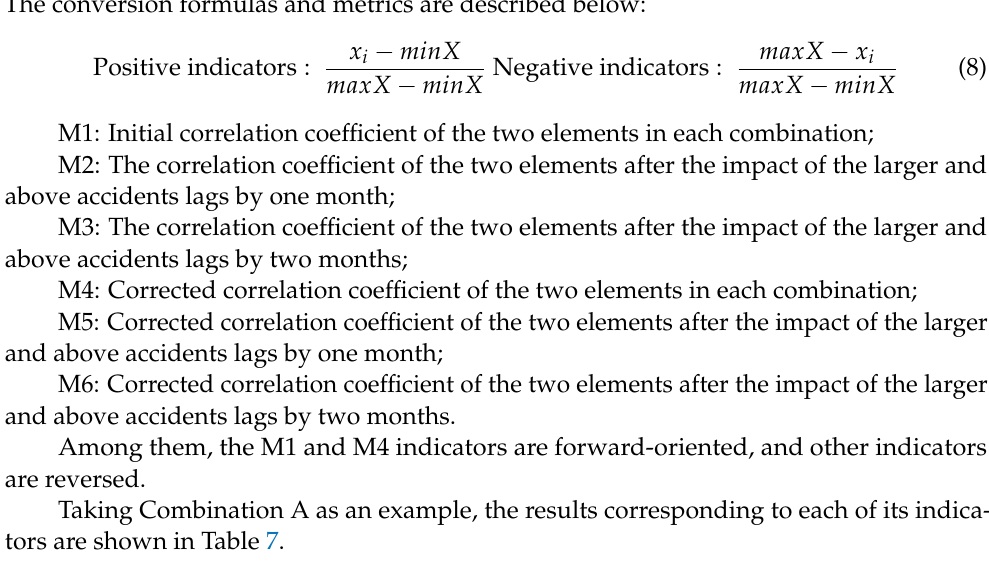
Table 7. Correlation coefficients for each indicator after forward and